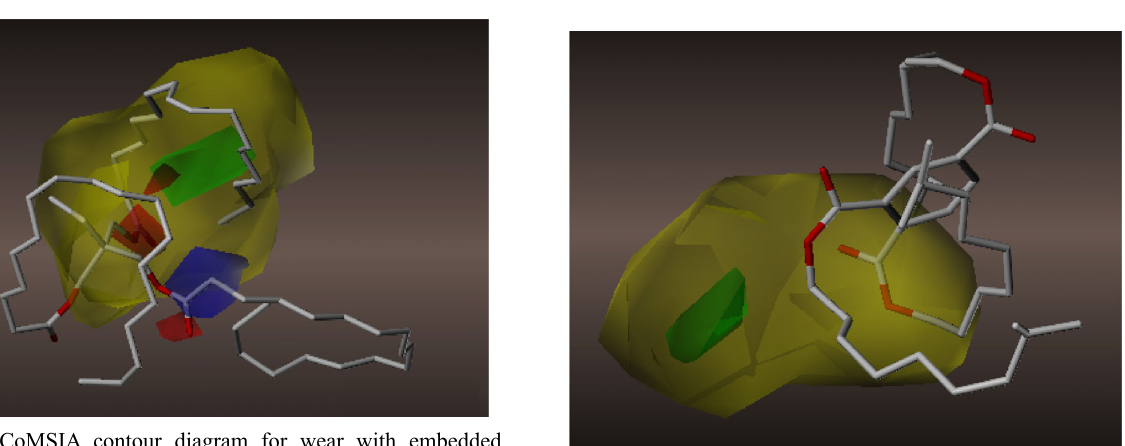
Fig. 41 CoMSIA contour diagram for wear with embedded TMPTO as reference for both steric and electrostatic fields. Green and yellow regions show where steric bulk is favored and disfavored, respectively. Blue region shows where positive charge is favored while red region shows where negative charge is favored.